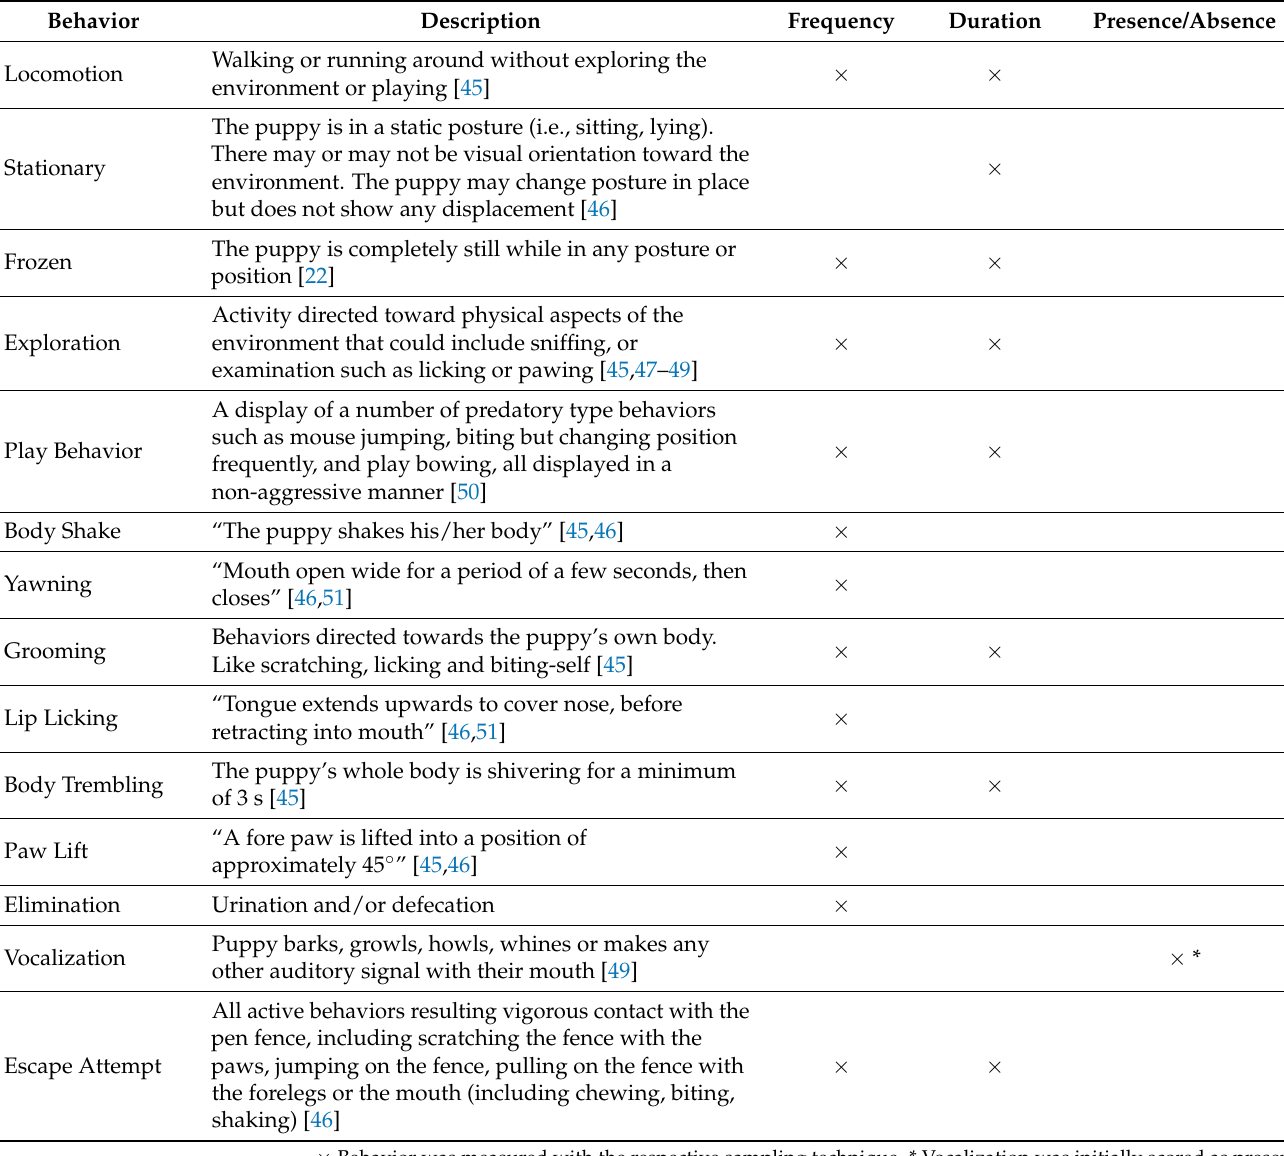
Table 1. Ethogram used to score puppy behavior in the isolation